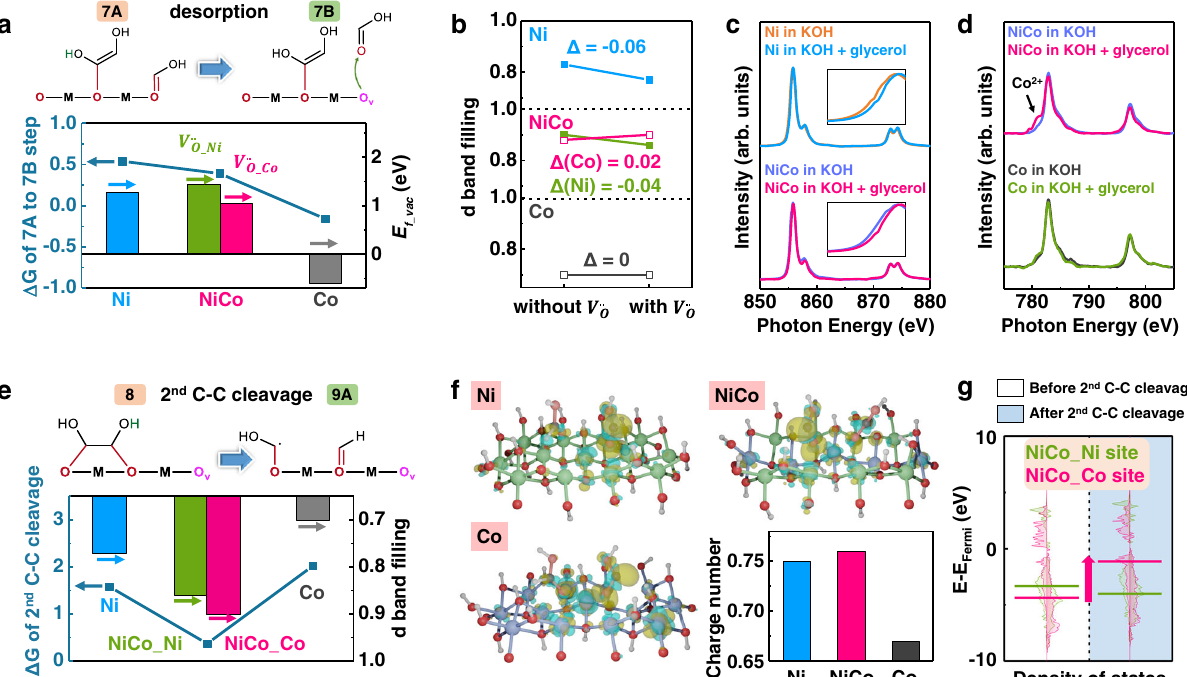
Fig. 4 The impact of oxygen anion deintercalation process on the desorption step and 2 nd C – C bond cleavage step. a The free energy barrier of the desorption step (7A → 7B) and the energy for the deintercalation of one oxygen anion from the hydroxide lattice ( E f_vac ) for Ni, NiCo, and Co hydroxide. b The change in d -band fi lling of the metal sites before and after oxygen anion deintercalation from the lattice. V :: is referred to oxygen vacancy. c The Ni L-edge and O d Co L-edge soft X-ray absorption spectra (sXAS) of Ni, NiCo, and Co hydroxide after operating at 1.624V (vs. RHE) in 1M KOH with/without 0.1M glycerol. The insets in c are the corresponding magni fi ed images of the pre-edge. The area of sXAS spectra were normalized to be 1. e The free energy barrier of the 2 nd C – C bond cleavage step (8 → 9A) and the d -band fi lling before 2 nd C – C bond cleavage of Ni, NiCo, and Co hydroxide. NiCo_Ni and NiCo_Co represent the Ni sites and Co sites on NiCo hydroxide, respectively. f The charge density difference plots and the bader charge analysis of the cleaved molecule on Ni, NiCo, and Co hydroxide after the 2 nd C – C bond cleavage. The yellow area indicates the charge accumulation, while cyan area indicates the charge depletion. g The DOS of NiCo hydroxide before (white area) and after (green area) the 2 nd C – C bond cleavage. The lines indicate the corresponding band